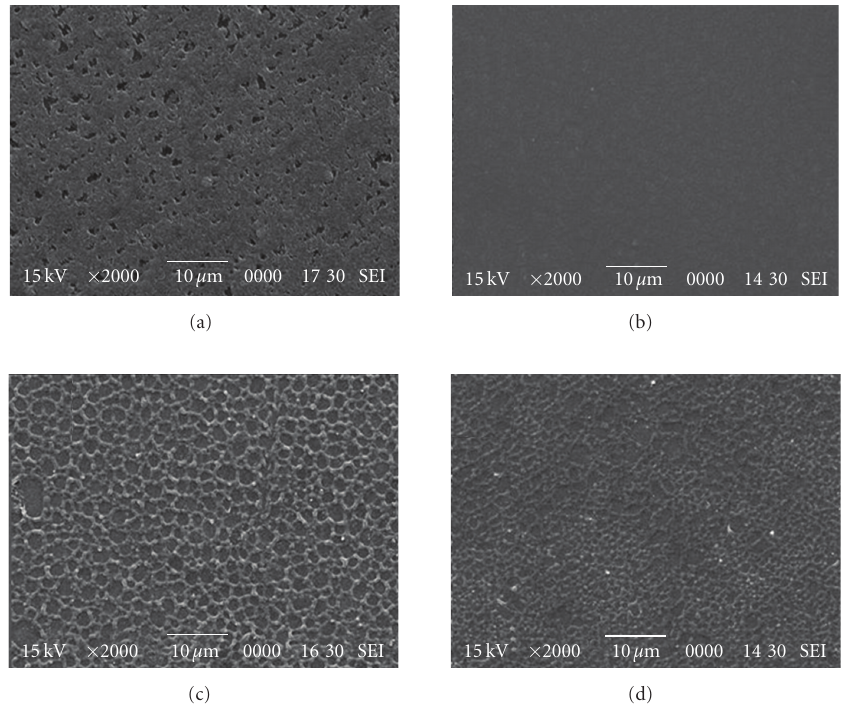
Figure 6: SEM images of the polymer surfaces made at 5000 × . (a) PU shows a rough surface. (b) The surface of PU-NH 2 displays a relatively flat surface. (c) and (d) The surfaces of PU-HA 1 and PU-HA 4 show a semiporous structure.